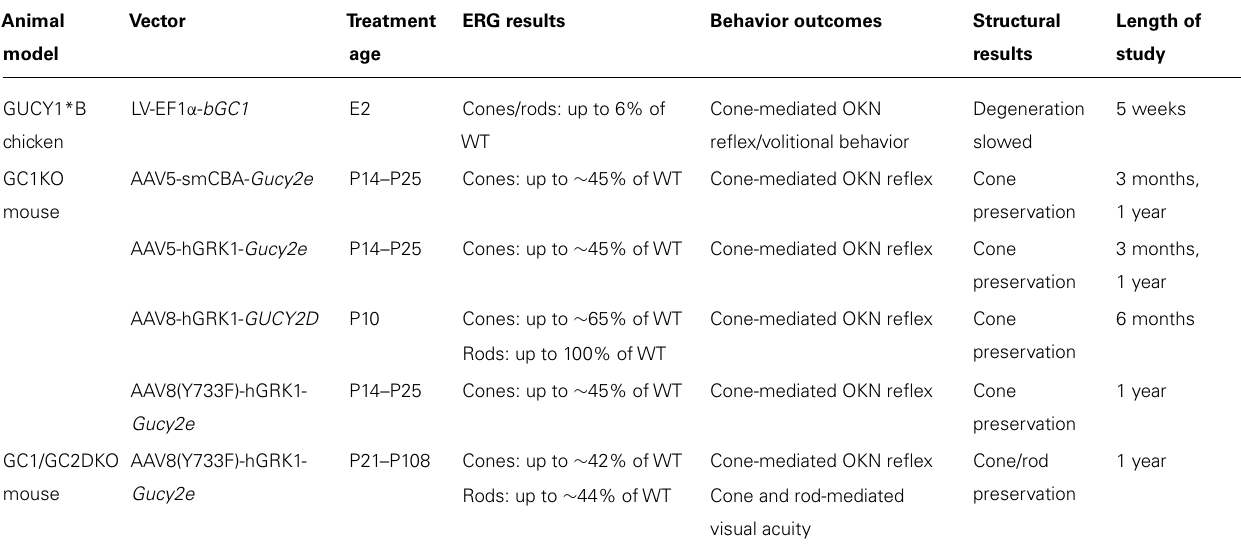
Table 1 | Summary of proof of concept experiments.